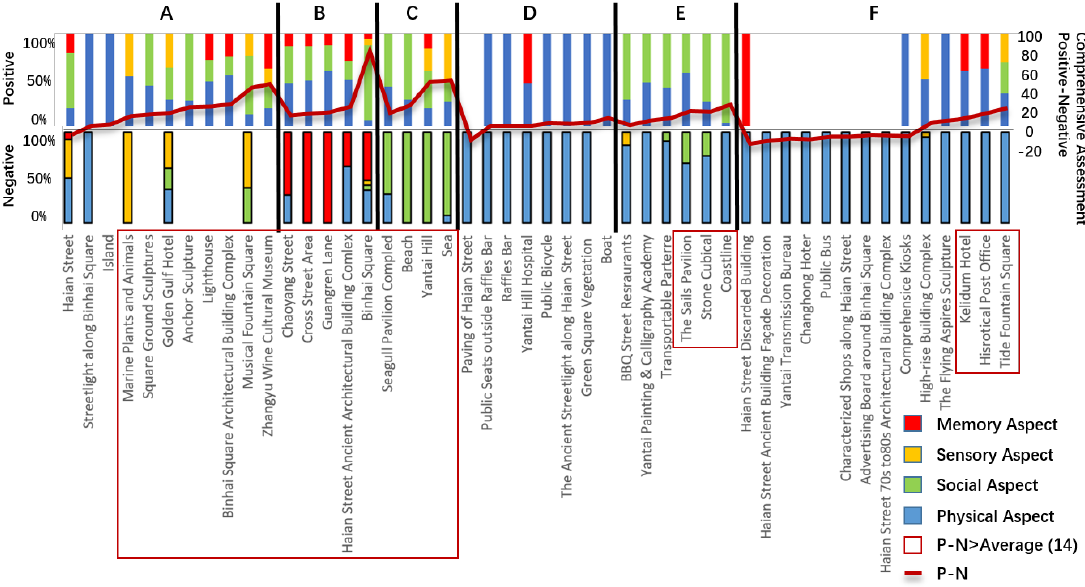
Figure 6. Overall Assessment Table.